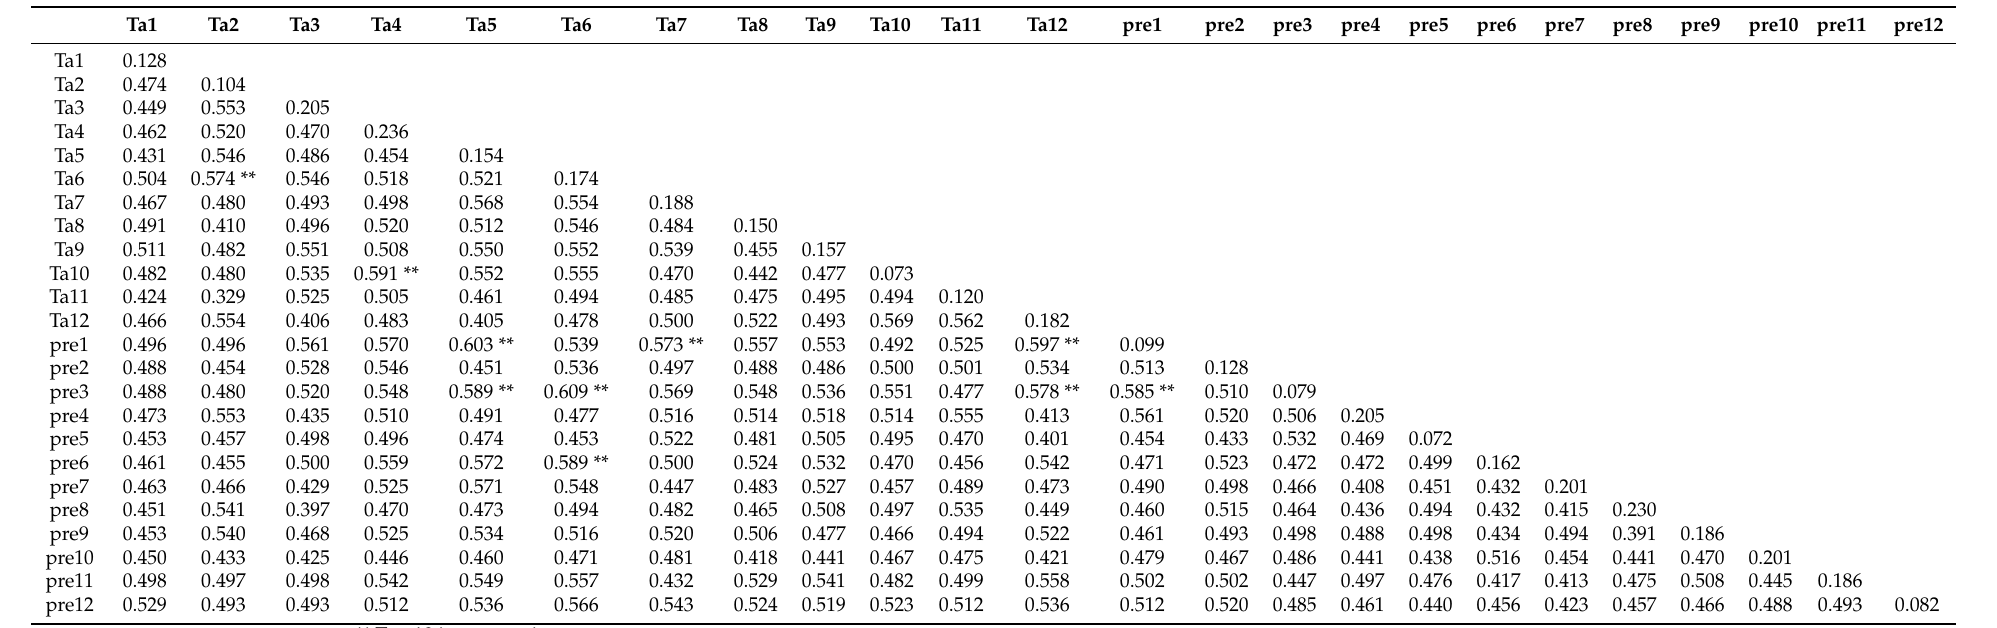
Table A3. Interpretation of LOS changes by multi-element